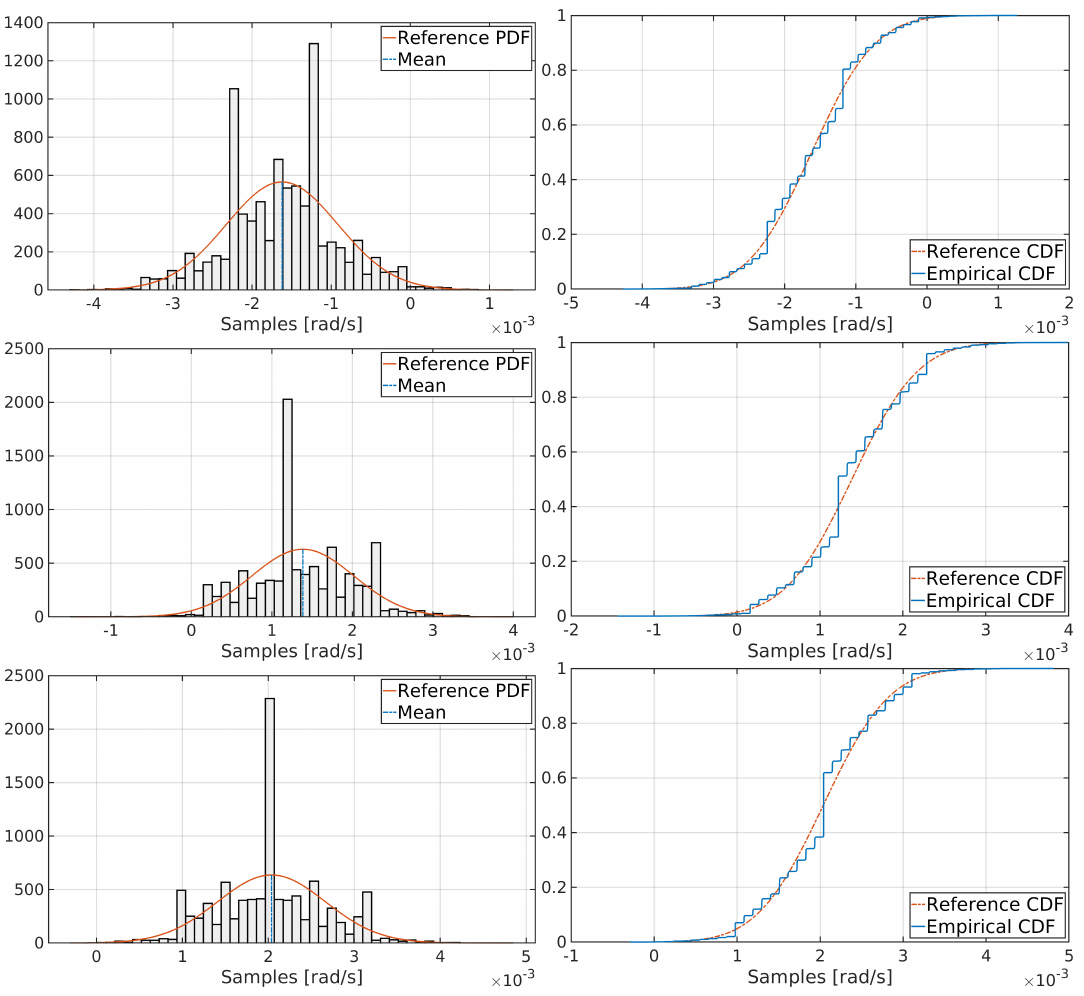
Figure 4. Graphical analysis of normal distribution for X, Y and Z MPU-6000 gyroscopes,